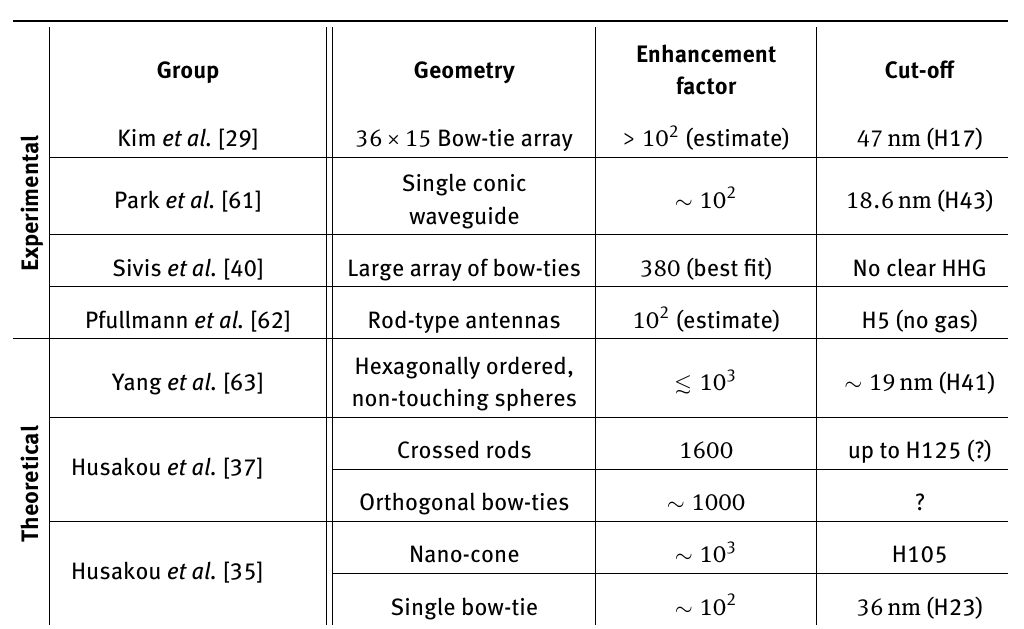
Figure 5: Schematic ( a ) and measurement ( b ) of a typical high-harmonic spectrum, from argon. Table 1: Comparison of the types and parameters of different plasmon-assisted HHG schemes, experimental and theoretical, since 2008. Harmonic numbers, if not given directly in the original reference, have been calculated using the respective used or simulated central wave- length, which in all cases is around or above 800nm